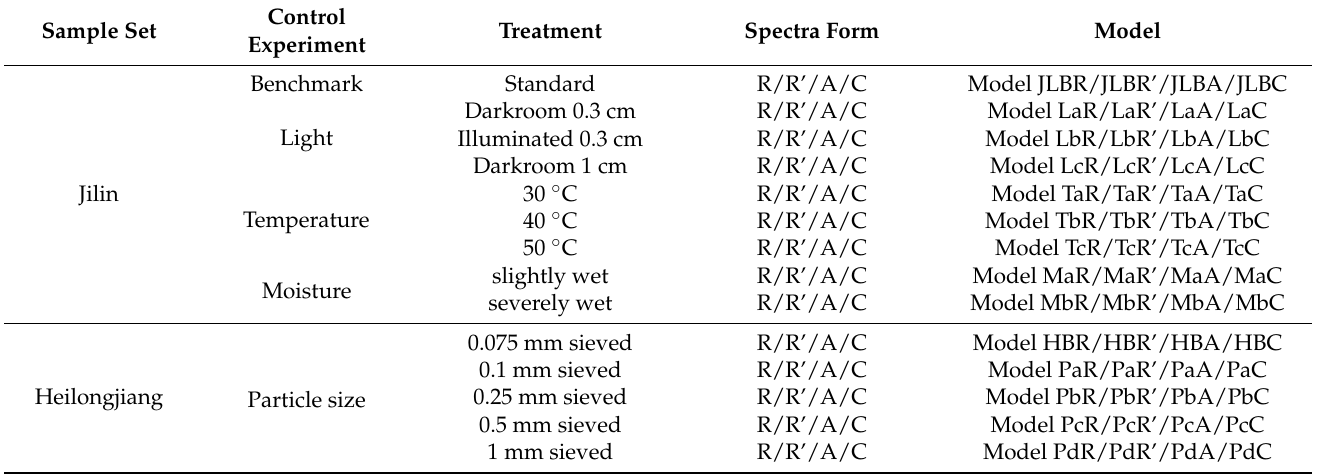
Table 2. A list of the PLSR models developed with different sample sets under different treatments and four forms of spectral transformations.